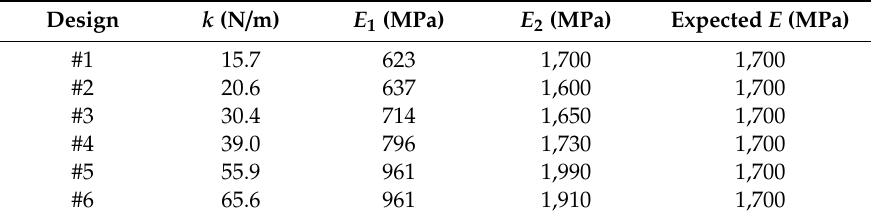
Table 2. Static Analysis: 3D Printed Nylon